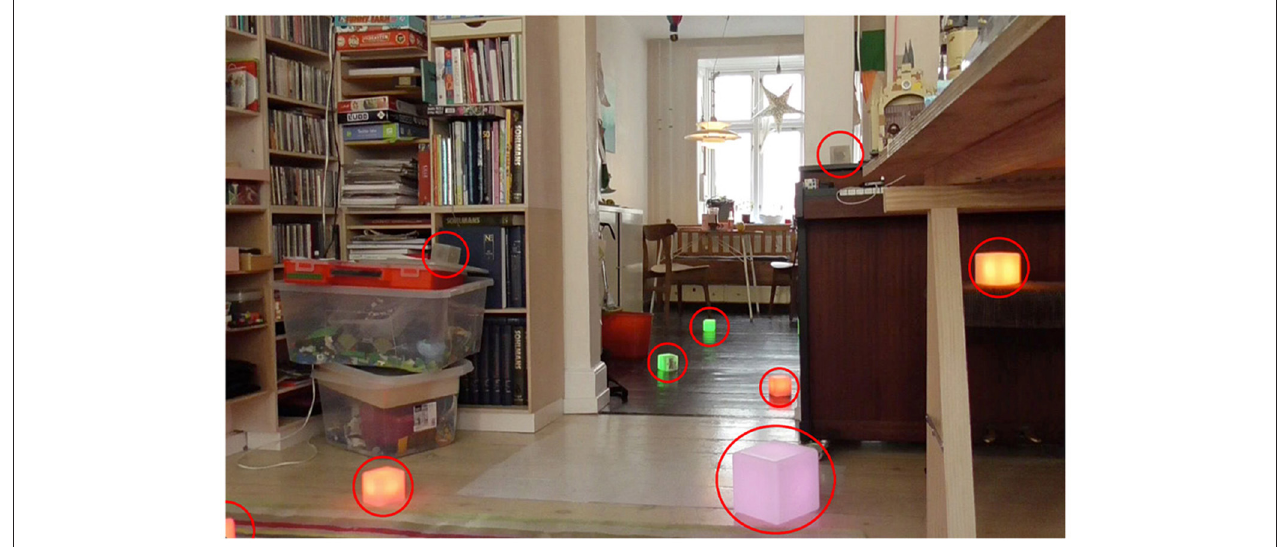
FIGURE 5 | A game set-up using both kitchen and living room including piano, piano bench and plastic